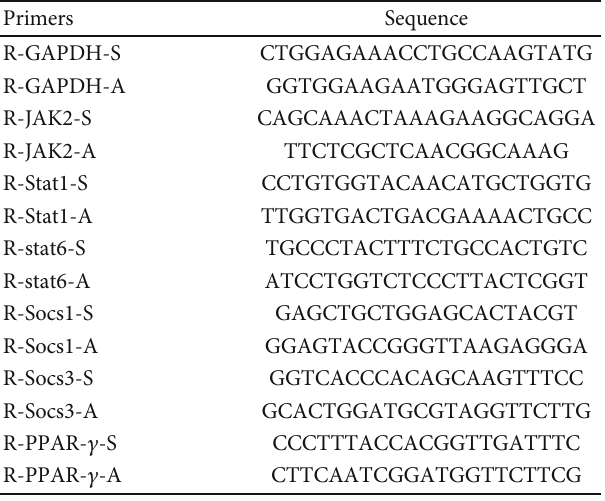
Table 3: Primers used for real-time